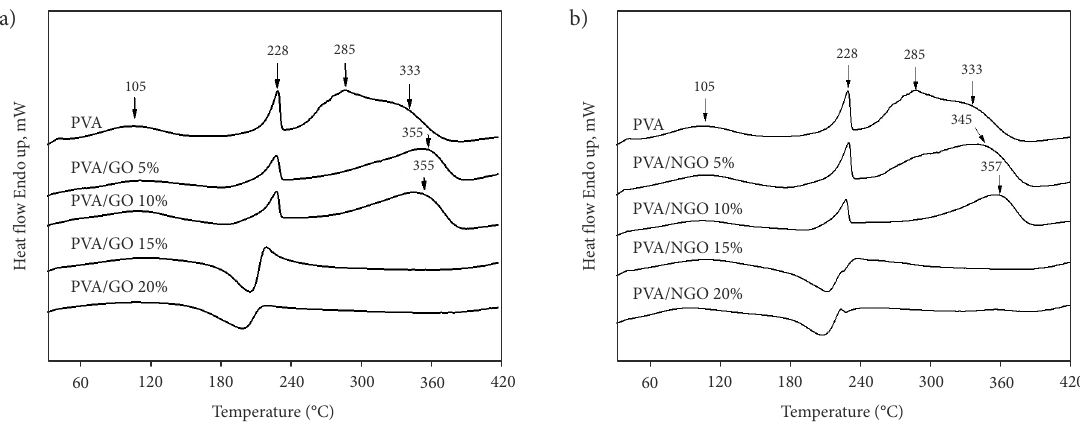
Figure 3. DSC of PVA/GO composite: a) – PVA and PVA/GO composite at size distribution of GO 300 nm; b) – PVA and PVA/GO composite at size distribution of GO 100